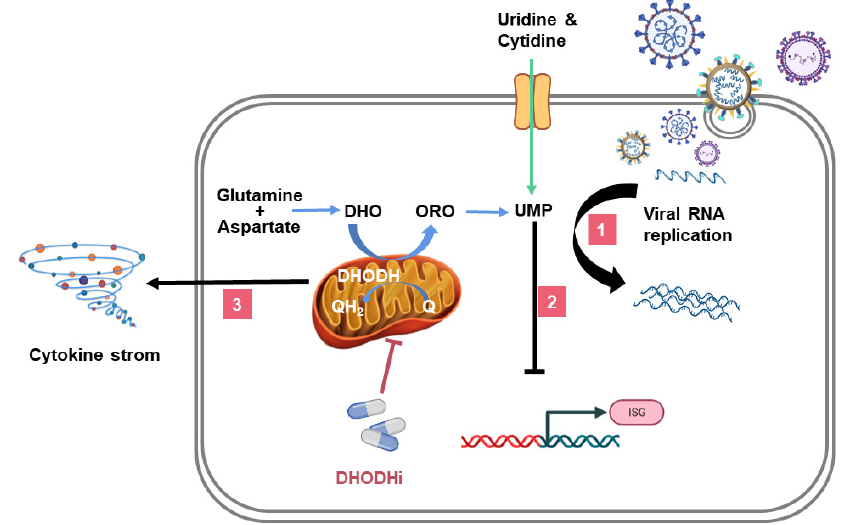
Figure 2. The role of DHODHi in viral infection. The triple mechanism of DHODHi is as follows: (1) DHODHi reduce the pyrimidine pool required for viral replication; (2) DHODHi activate ISGs expression; and (3) DHODHi suppress the inflammatory factor storm caused by the virus. The mechanisms by which human cells obtain pyrimidines: the de novo biosynthesis (blue arrow) and the salvage pathway (green arrow). UMP, uridine monophosphate; DHO, dihydroorotate; ORO, orotate; Q, ubiquinone; QH 2 , ubiquinol; ISG, interferon-stimulated gene.